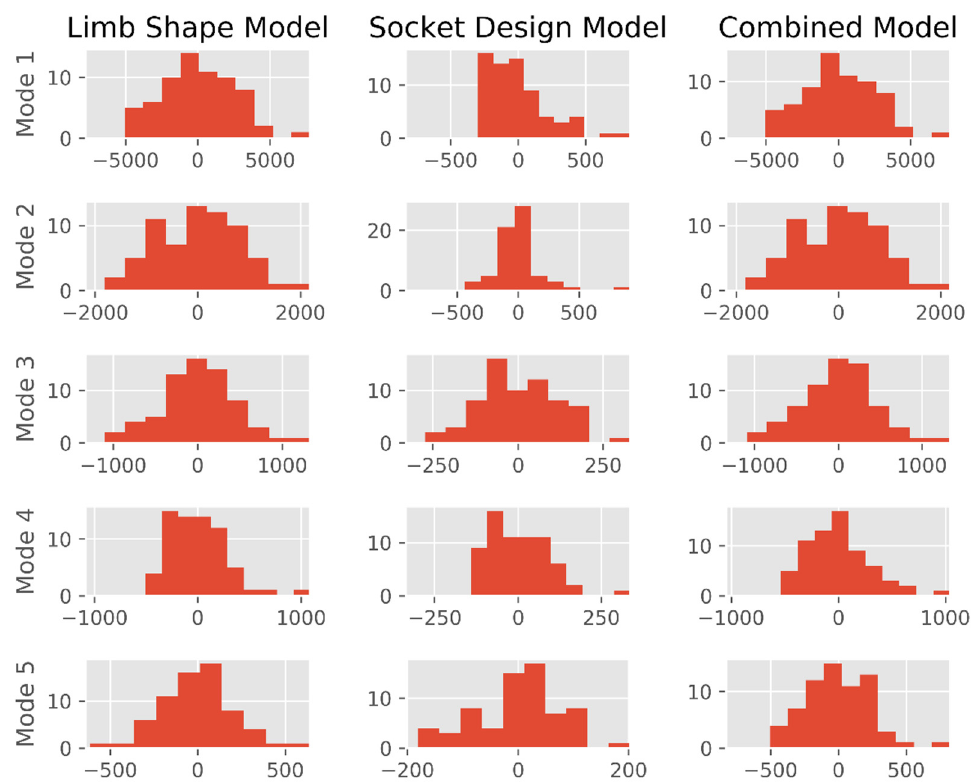
Figure A1. Histograms of training dataset mode scores for the SLM, SDM and SLDM. Greatest deviation from normal distributions is observed for the statistical design model. Table A1. Correlations between statistical limb model mode scores and participant metadata: Correlations Between SLM Modes and Participant Metadata